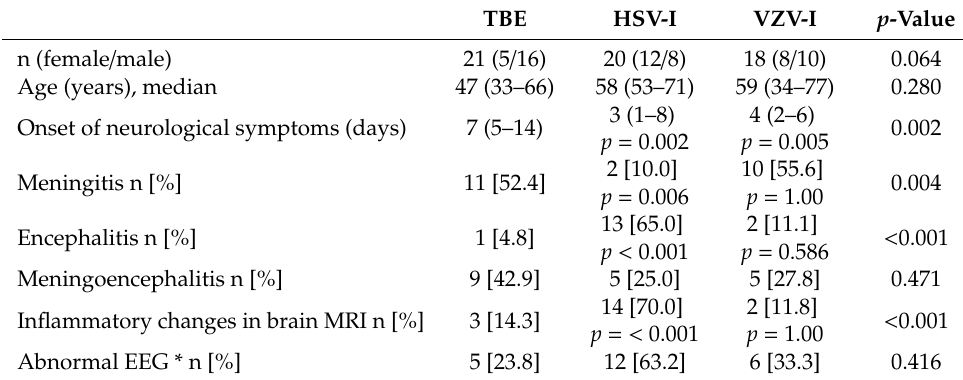
Table 1. Demographic and clinical